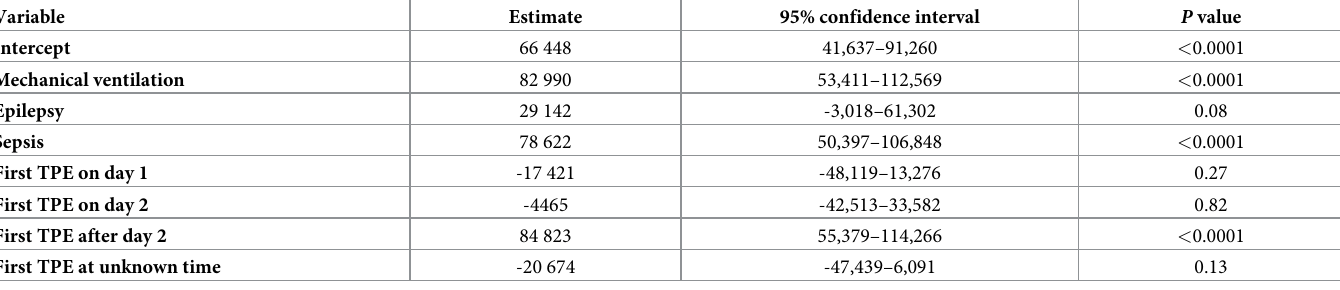
Table 4. Results of the linear mixed-effects model analyzing cost (in USD) in patients with thrombotic thrombocytopenic purpura treated with therapeutic plasma exchange.